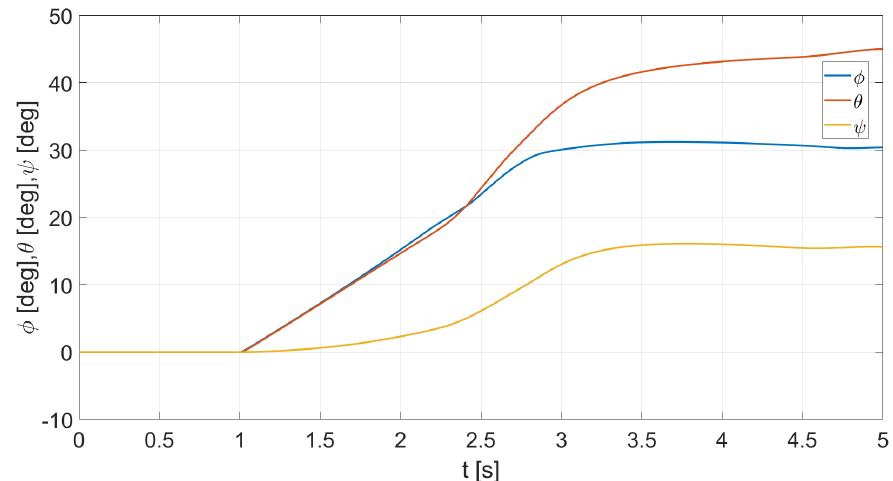
Figure 5. Angular response of UAV—PID-SDRE control mode, t f = 4 s.